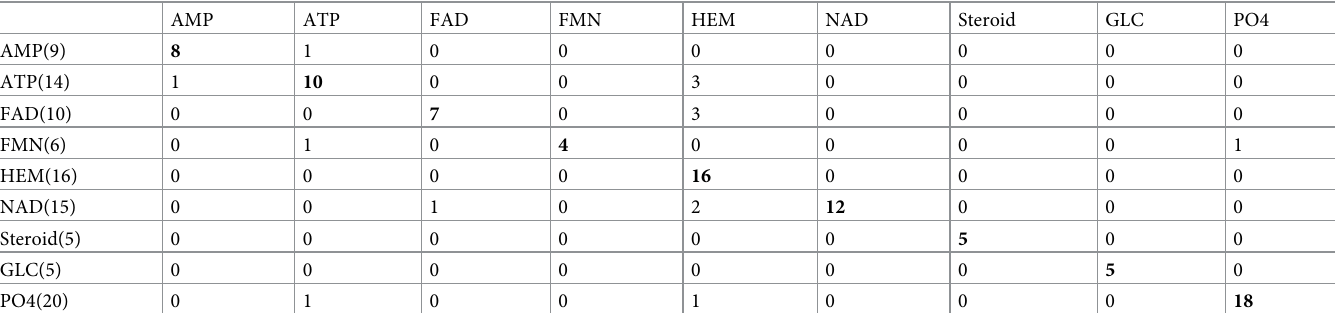
Table 4. Correctly classified and misclassified number of binding sites in each ligand group for Kahraman dataset using nearest mean